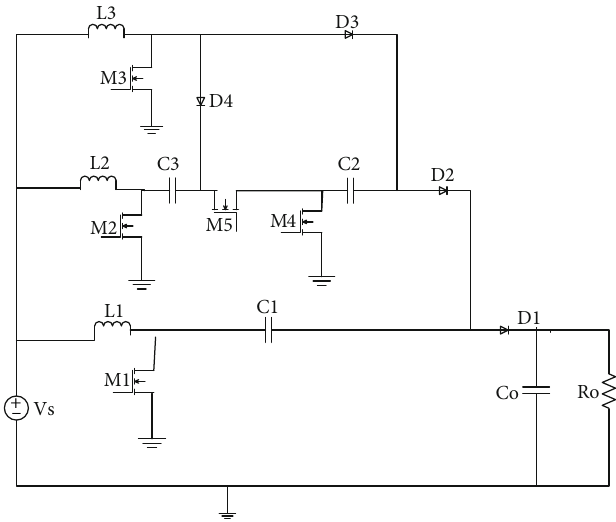
Figure 2: Circuit diagram of the proposed